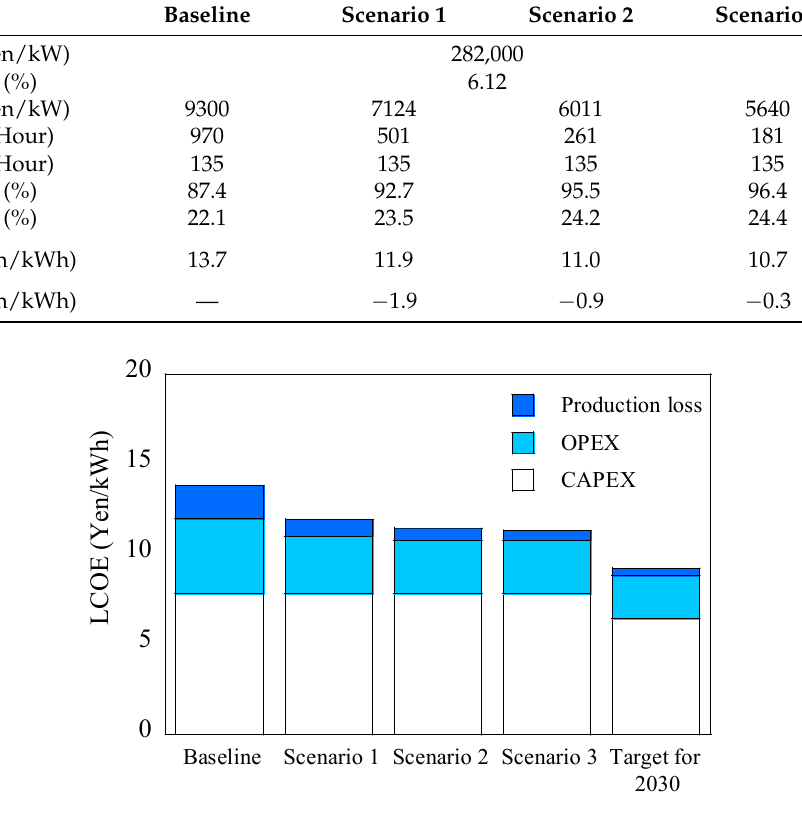
Figure 6. Predicted LCOE for baseline case, three scenarios and the target for 2030.